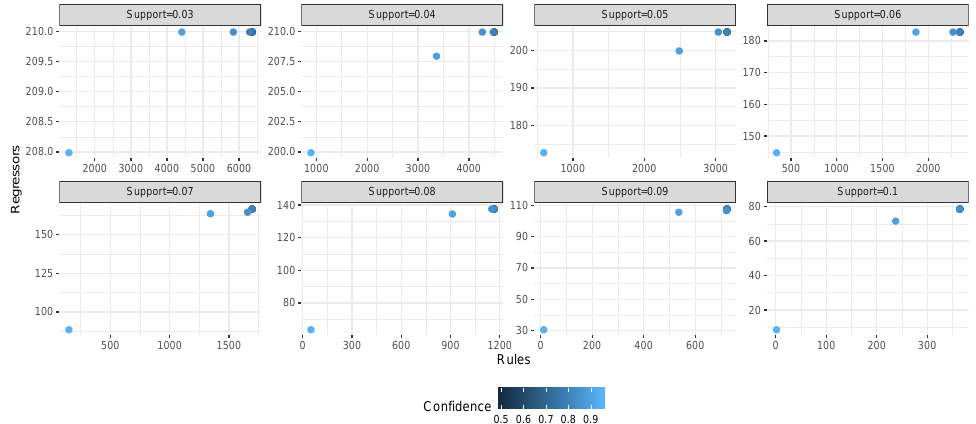
Figure 10. Rules and regressors for each experimental setting in the Crime and Communities